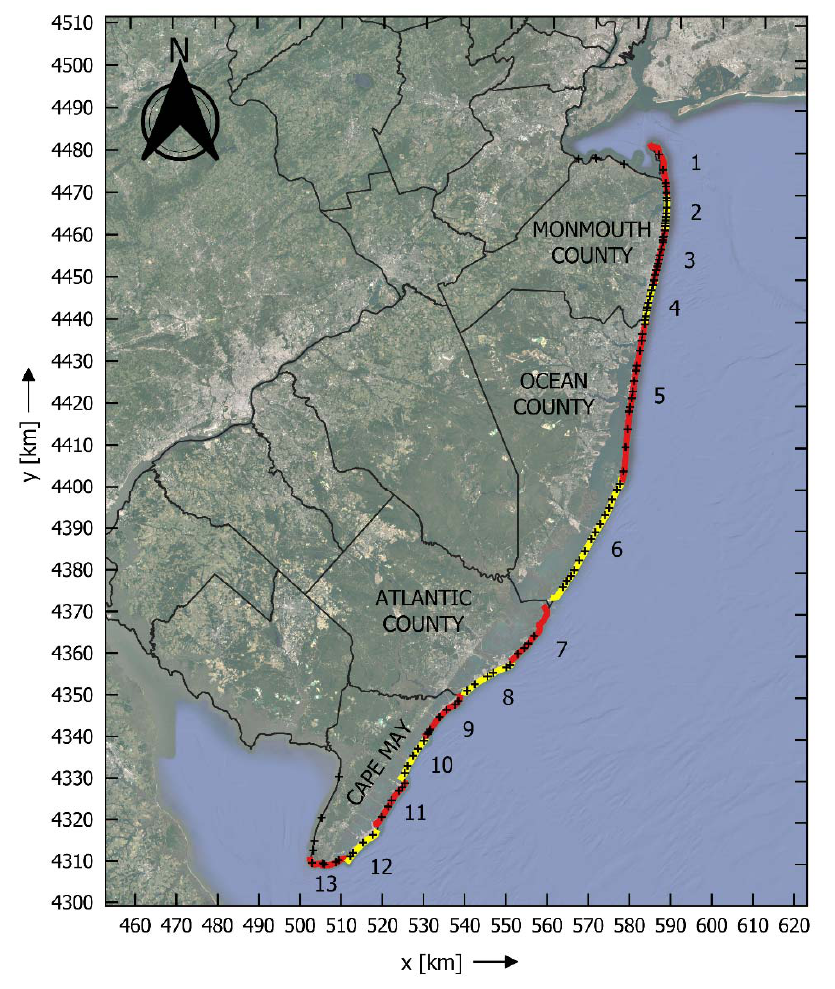
Figure 2. Study area location. Alternating red and yellow lines depict NJ shoreline segments utilized by Lemke and Miller [26] to produce the storm erosion potential climatology. Segments are numbered from north to south, with #1 at Sandy Hook and #13 at Cape May. Black lines depict NJ County borders with the four Atlantic coastal counties labeled accordingly. Black markers depict NJBPN survey locations. Map coordinate system is NAD83/UTM Zone 18N in kilometers.